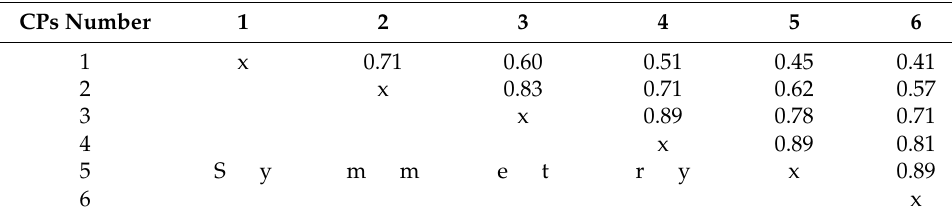
Table 8. The values of the linear correlation coefficient ρ . CPs Number